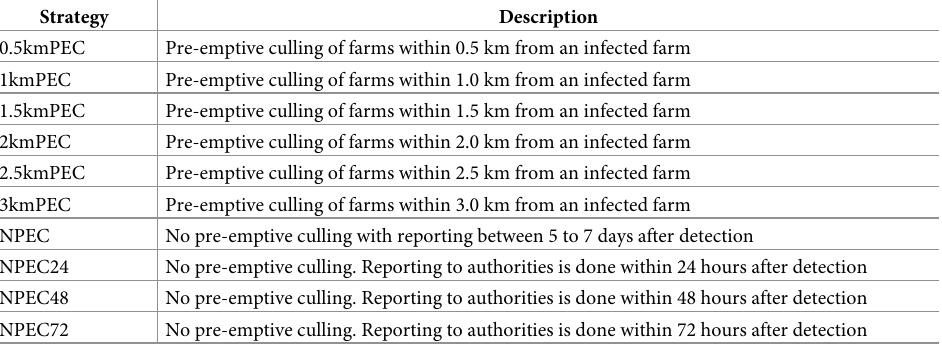
Table 2. Control strategies used when simulating HPAI spread in Central Luzon,